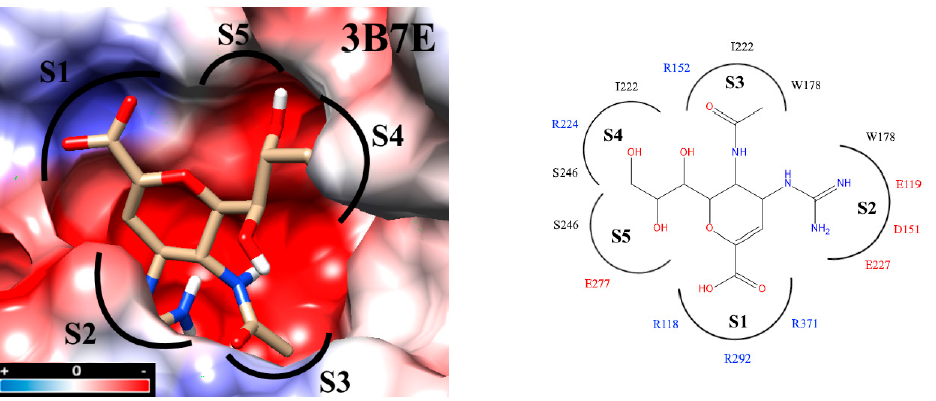
Figure 3. Docking inside to the active site of neuraminidase subtype N1 (PDB code: 3B7E) with molecule zanamivir. The active site is divided into five subsites (S1 to S5) and these subsites are composed of acidic (red), basic (blue) and hydrophobic (black) amino acids. The interaction analyses were carried out with PrPx-Phyton v0.8 and Autodock Vina. The colored surfaces were generated with Coulombic Surface Coloring under UCSF Chimera 1.11.2. Red resp. blue surfaces represent the regions with acidic or basic amino acids, respectively. White surfaces are hydrophobic regions. Right side panel: schematic drawing of the active site with bound zanamivir and the five subsites S1 to S5.